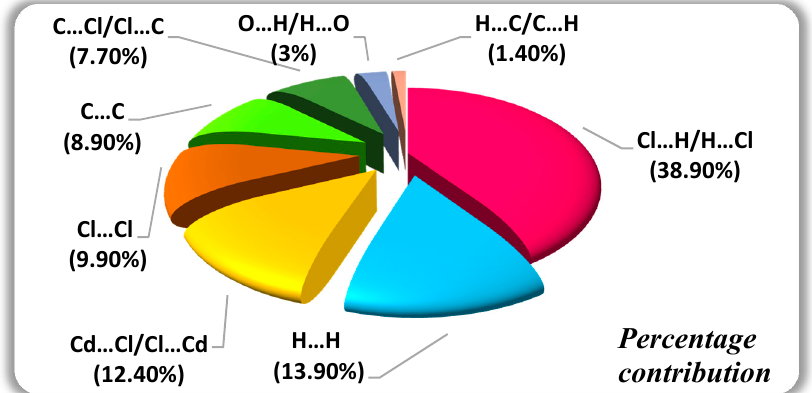
Figure 8. Contacts in (C 6 H 8 Cl 2 N 2 ) 2 [Cd 3 Cl 10 ]·6H 2 O crystals.